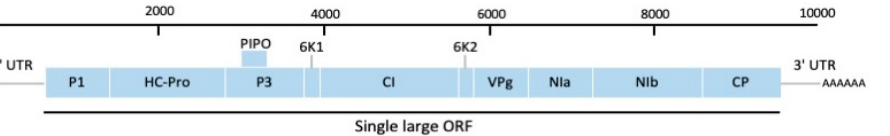
Figure 2. Schematic genome representation of species Yam mosaic virus (YMV), genus Potyvirus , family Potyviridae . The 11 functional proteins represented are P1: first protein (translation, modulator of replication), HC-Pro: helper component protease (silencing suppression and aphid transmission), P3: third protein (virus replication and movement), 6K1 (formation of replication vesicles), CI: cylindrical inclusion protein (virus movement and replication), 6K2 (formation of replication vesicles), VPg: viral genome-linked protein (translation, virus movement and replication), NIa: major protease of small nuclear inclusion protein (polyprotein processing), NIb: large nuclear inclusion protein (RNA-dependent RNA polymerase), CP: coat protein (virus movement, virion formation, and aphid transmission) and PIPO: pretty-interesting-potyvirus-ORF (virus movement).